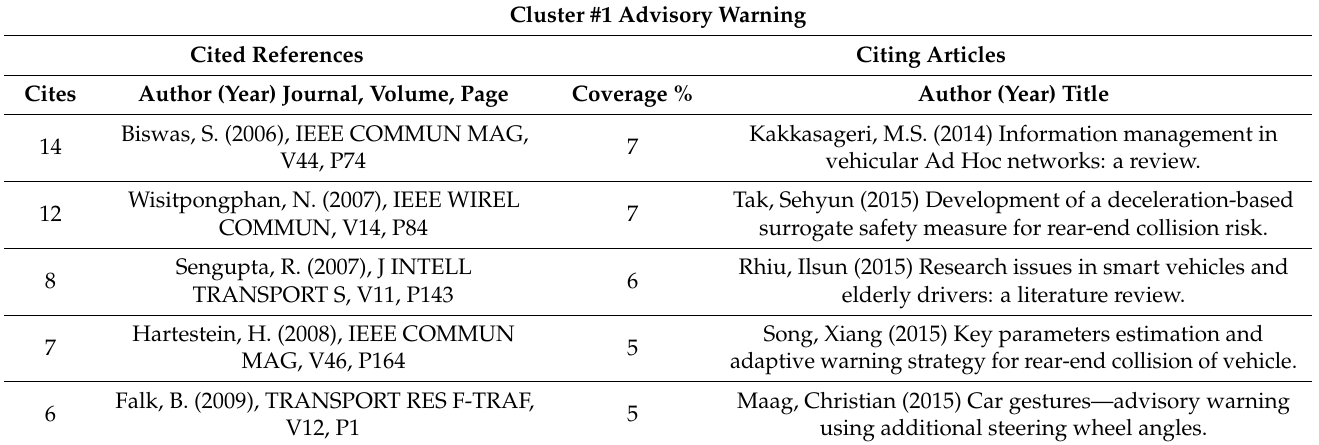
Table 3. Cited references and citing articles of Cluster #1.